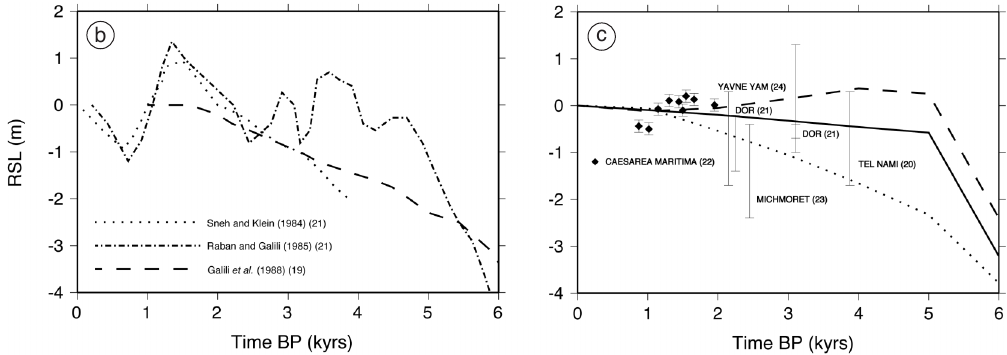
Fig. 14b,c. In (b) we have reproduced tentative RSL curves from the existing literature, while in (c) we compare the data of Sivan et al. (2001, 2004) with results based on the same models previously considered in fig.